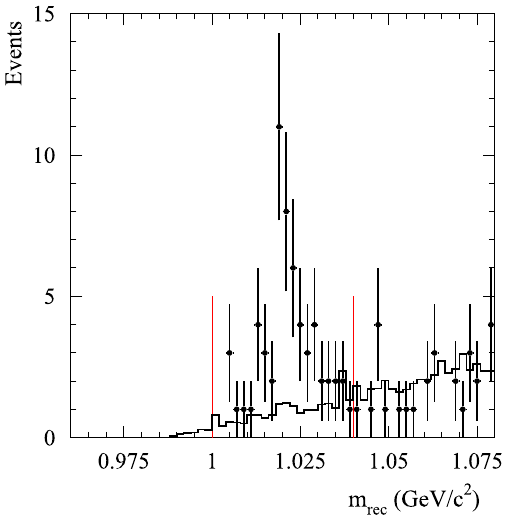
Fig. 10 The m rec distributions for data events (points with error bars). The histogram represents a sum of the simulated distributions for e + e − → K ∗ K → K + K − π 0 events and events of the background processes (1). The vertical lines indicate the region 1 . 00 < m rec < 1 . 04